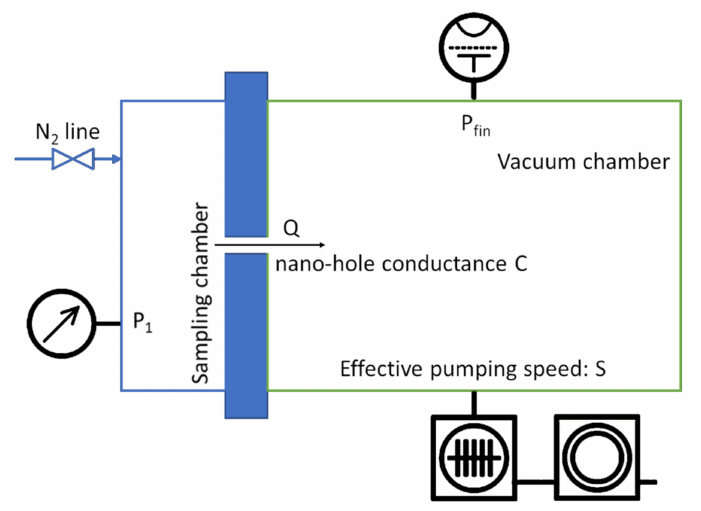
Figure 7. Schematic of the experimental setup. The sampling chamber (left) with a nitrogen inlet is connected to the vacuum chamber by the nanoscopic holes having a conductance C.